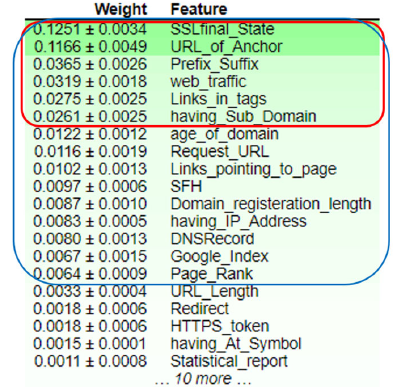
Fig. 7. Using Extra Trees classifier extracting the top fea- tures for the